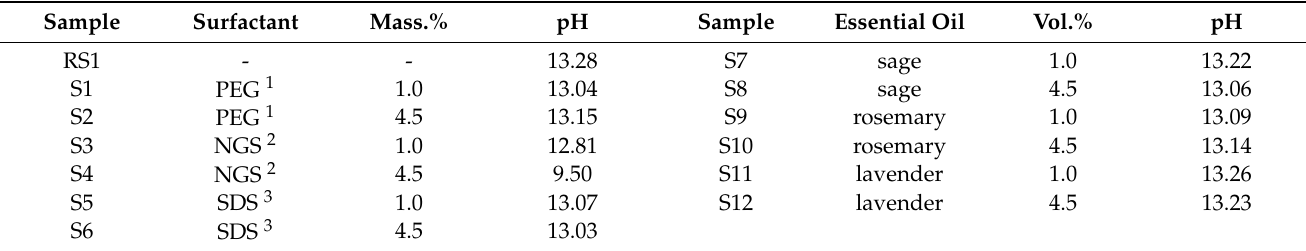
Table 1. Experimental conditions for the samples prepared at 200 ◦ C for 20